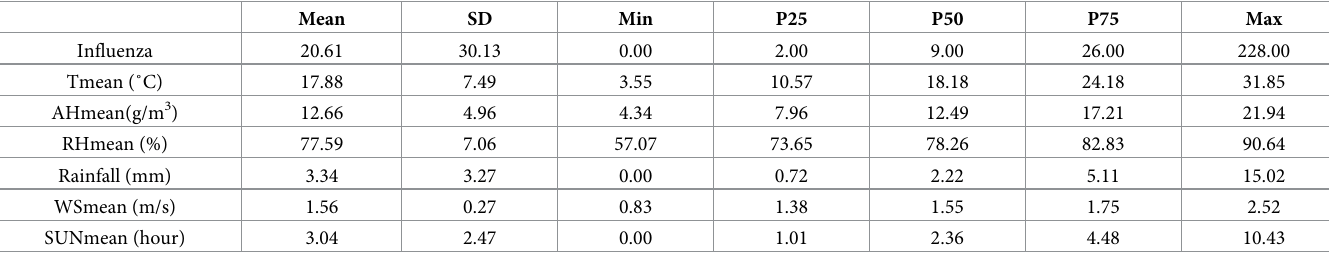
Table 1. Descriptive statistics of meteorological factors and influenza activity in Chongqing, China, 2012–2019. Mean SD Min P25 P50 P75 Max Influenza